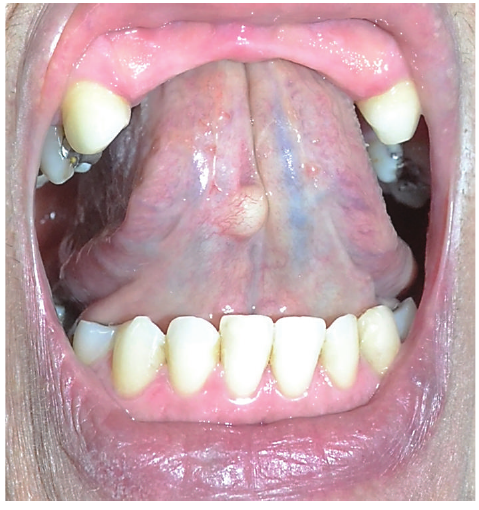
Figure 1: Clinical aspect of the lesion in right ventral tongue region.